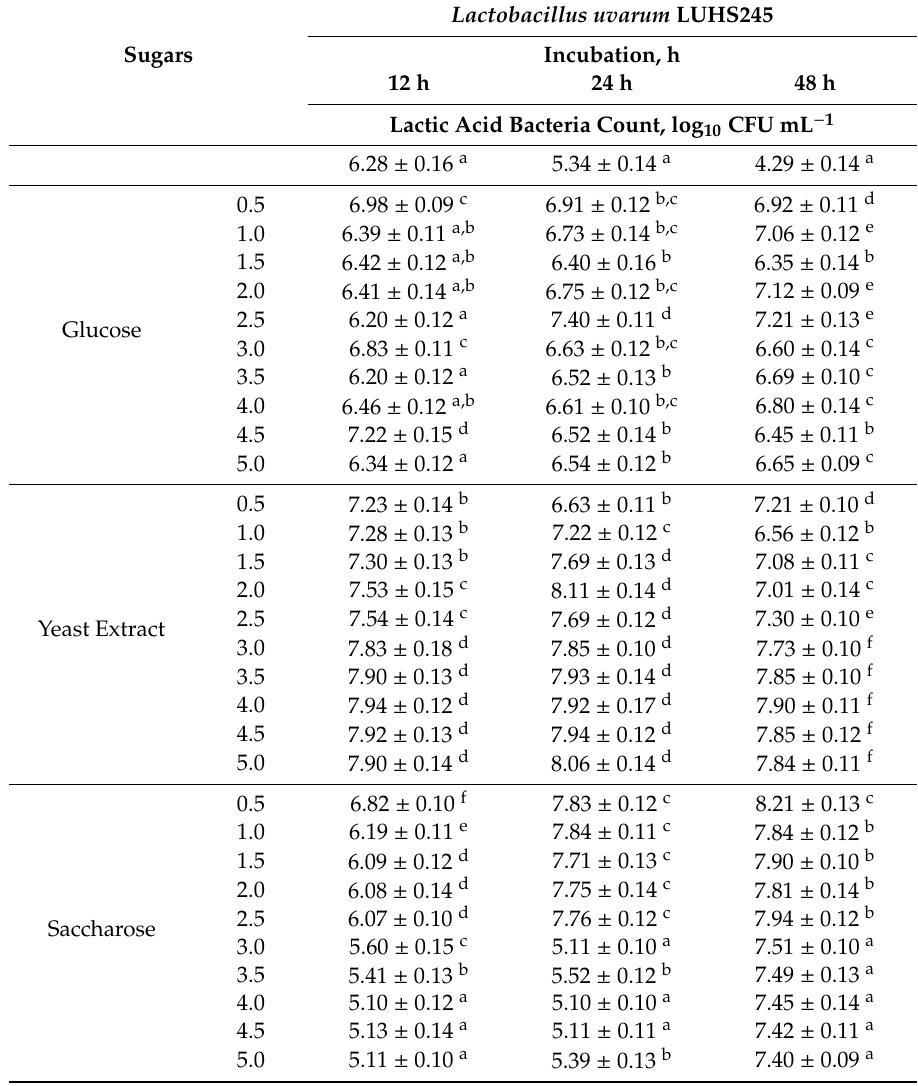
Table 3. Lactobacillus uvarum LUHS245 count in whey enriched with di ff erent quantities of glucose, yeast extract, and